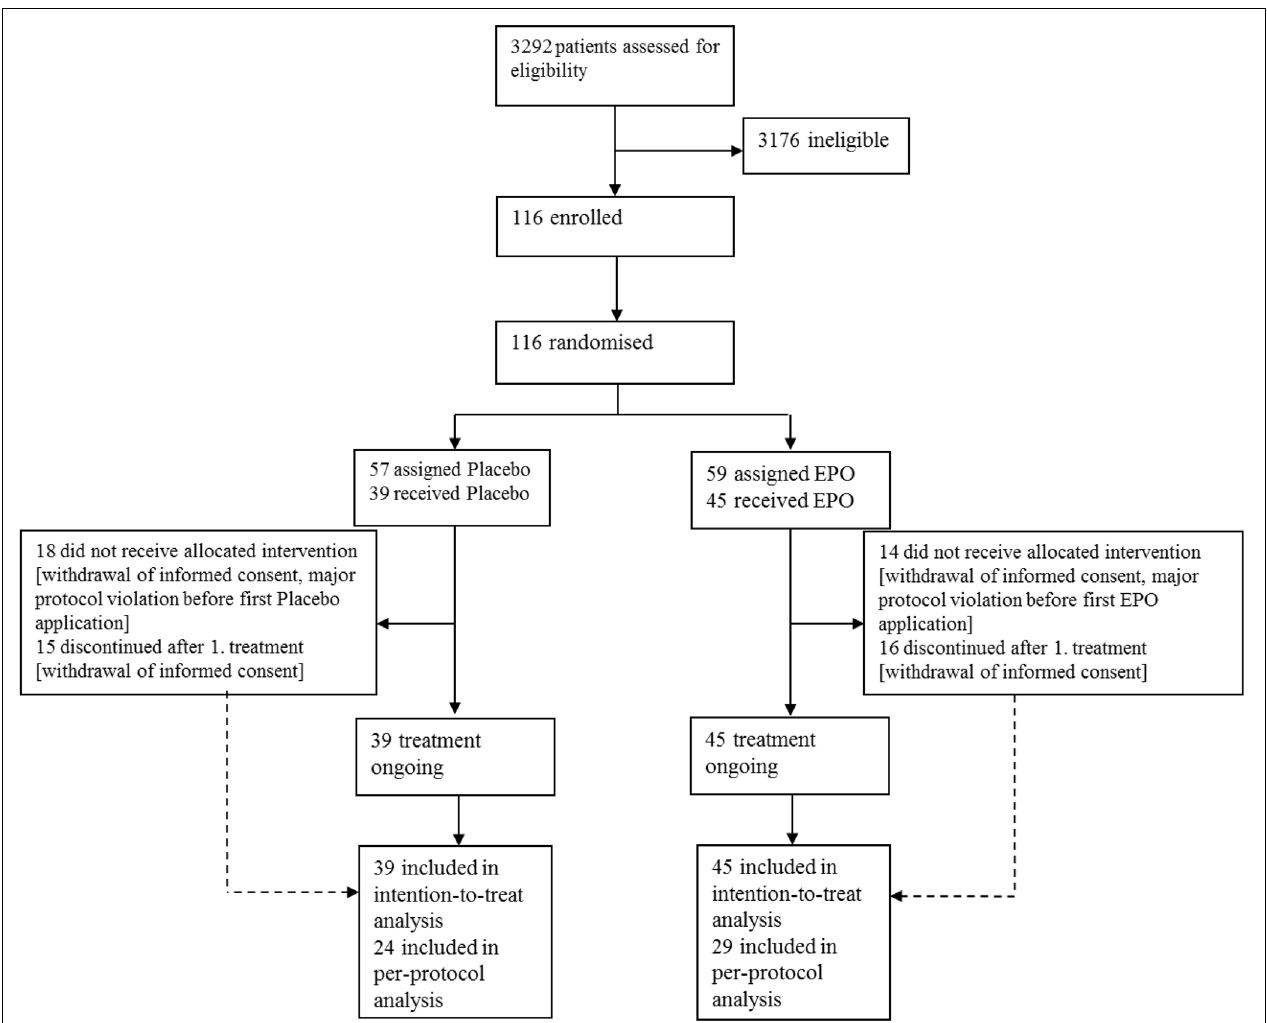
FIGURE 1 | Patient flow. Legend: Enrolment: patients with burn and scald injuries who met all inclusion criteria and none of the exclusion criteria were included. Allocation: centralized randomization (stratified by study center) patients were randomly allocated to the verum- or the placebo-treated group using a variable block size, patients received max. 11 study drug administrations. Follow-up: at Day 42, after 6 months, and 12 months past inclusion. Analysis: ITT analysis set: received at least one dose of study medication. PP set: received at least one dose of study medication but displayed major protocol violations until and including Day 21.